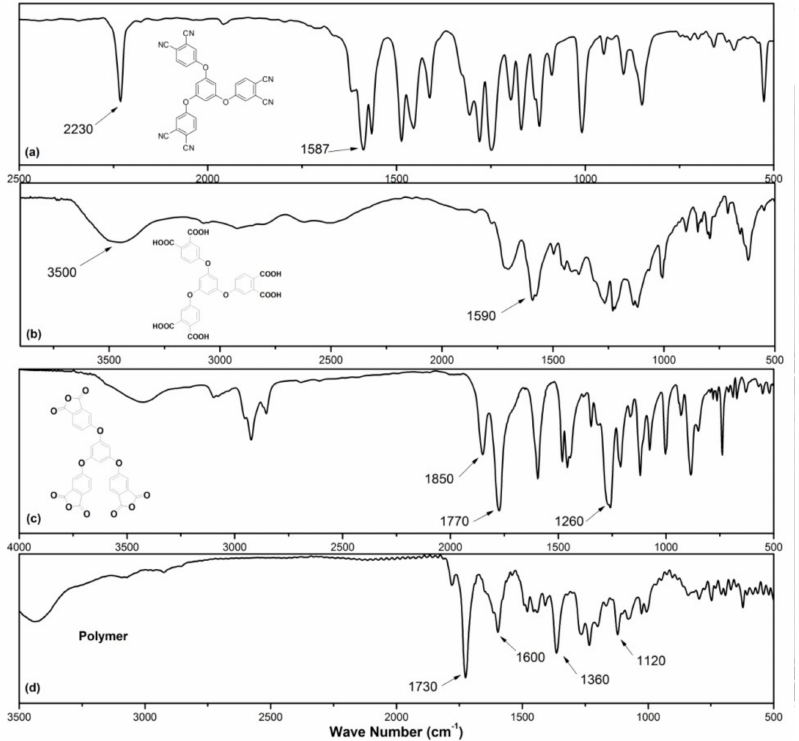
Figure 2. FTIR spectra of the product ( a – c ) and s-PI polymer ( d ).